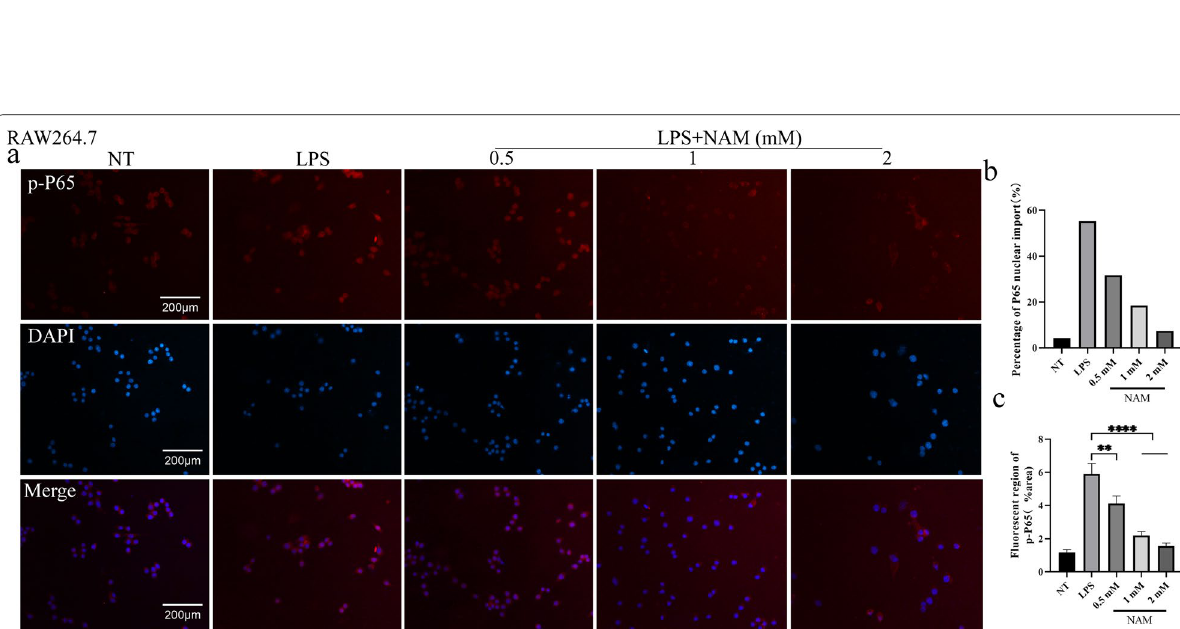
Fig. 8 The fluorescence intensity and nuclear import of p-P65 in RAW264.7 cells. The nucleus is blue and p-P65 is red. a Fluorescence intensity and nuclear import of p-P65 after different treatments. b Percentage of p-P65 nuclear